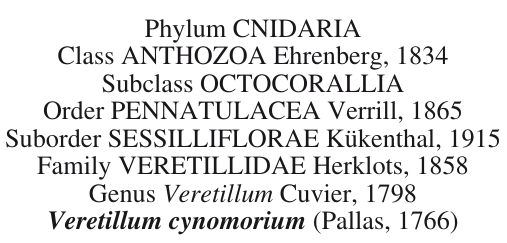
Table S1. – Taxonomic list of collected species with data of the material examined and notes on its